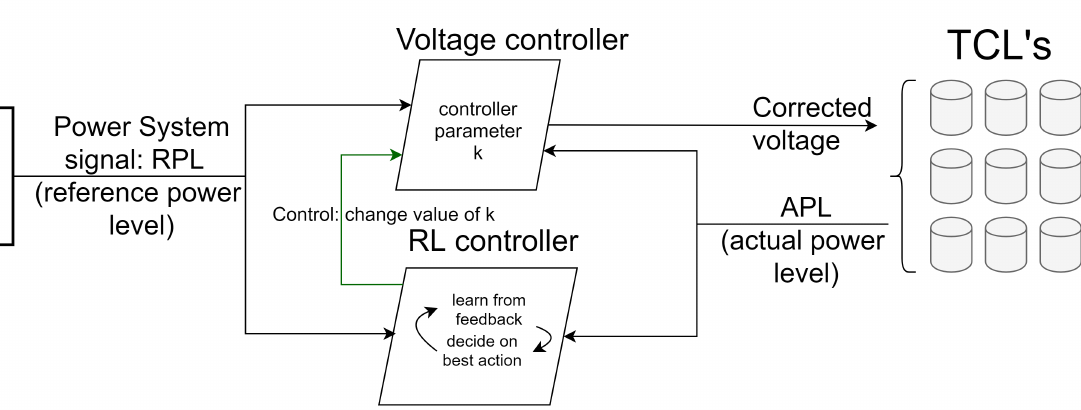
Figure 2. The approach of the proposed voltage control-based ancillary service and its interaction flows in the power